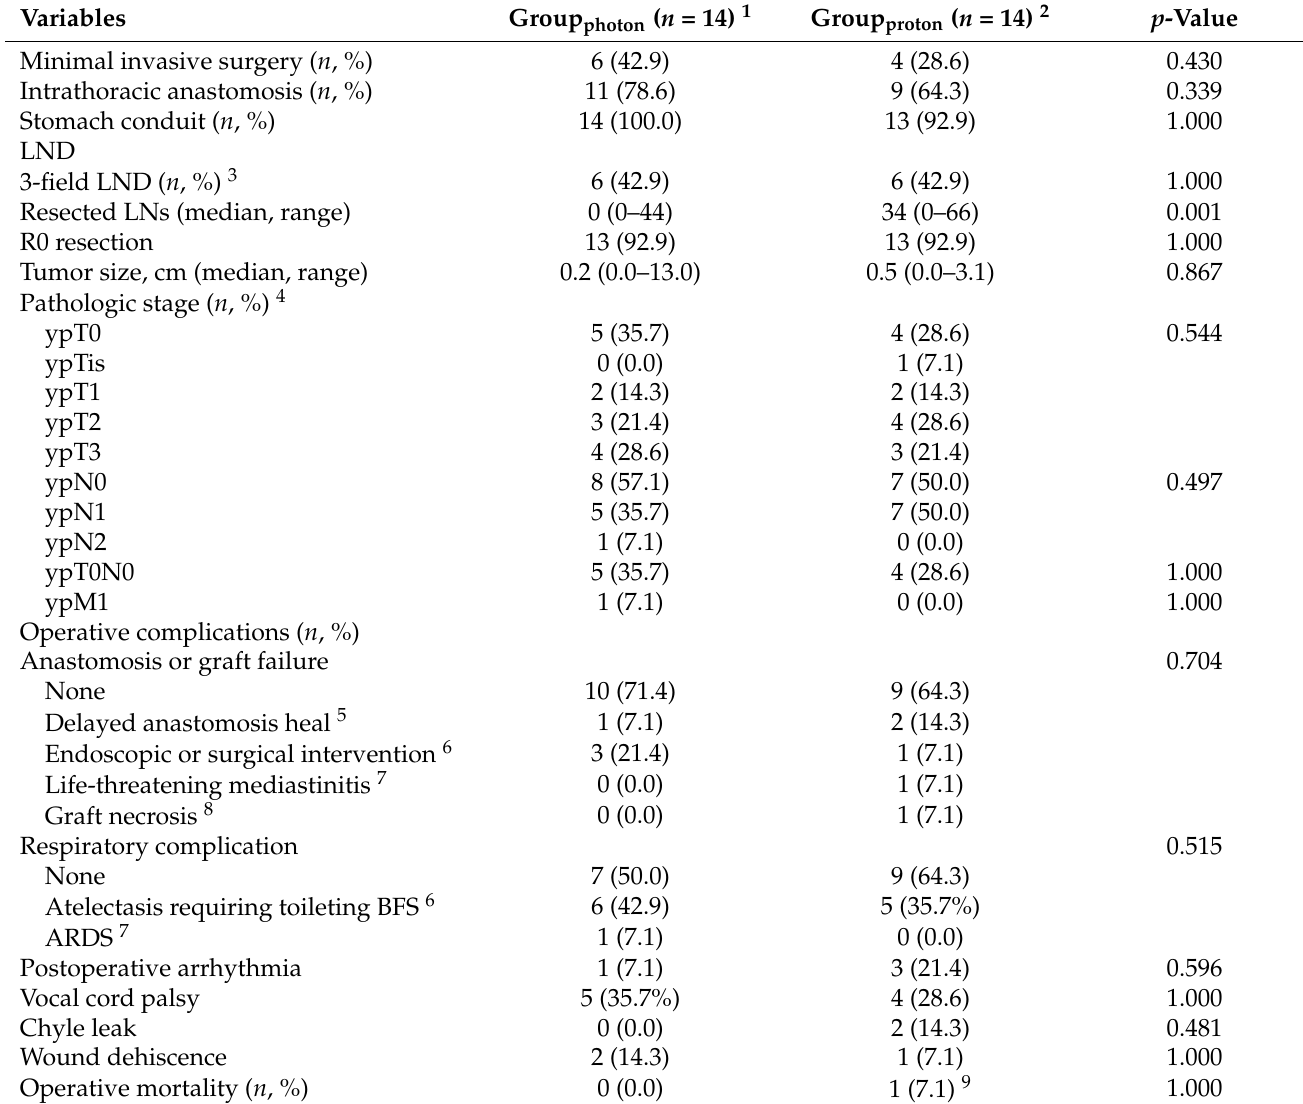
Table 3. Summary of surgical results for esophageal squamous cell carcinoma after neoadjuvant chemoradiotherapy according to the radiation modalities, photon, and